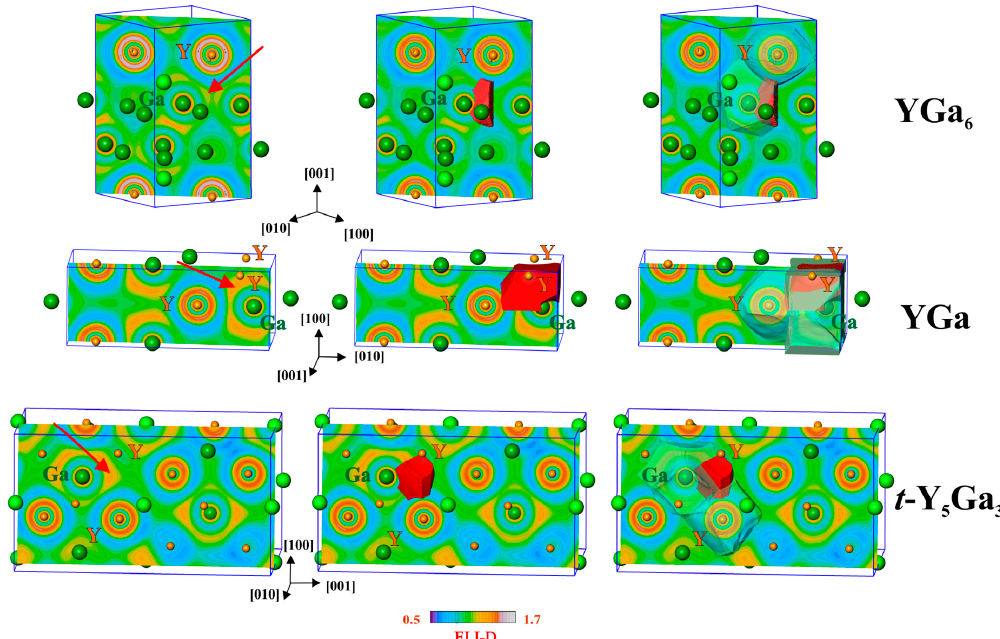
Figure 5. Electron localizability indicator (ELI-D) in YGa 6 (top), YGa (middle) and t -Y 5 Ga 3 (bottom): (left) distribution of ELI-D in the selected planes, the position of the selected attractor is marked by arrows; (middle) shapes of the ELI-D basins for the selected attractors; (right) positions of the selected basins within the atomic QTAIM basins which contribute to the selected interaction.